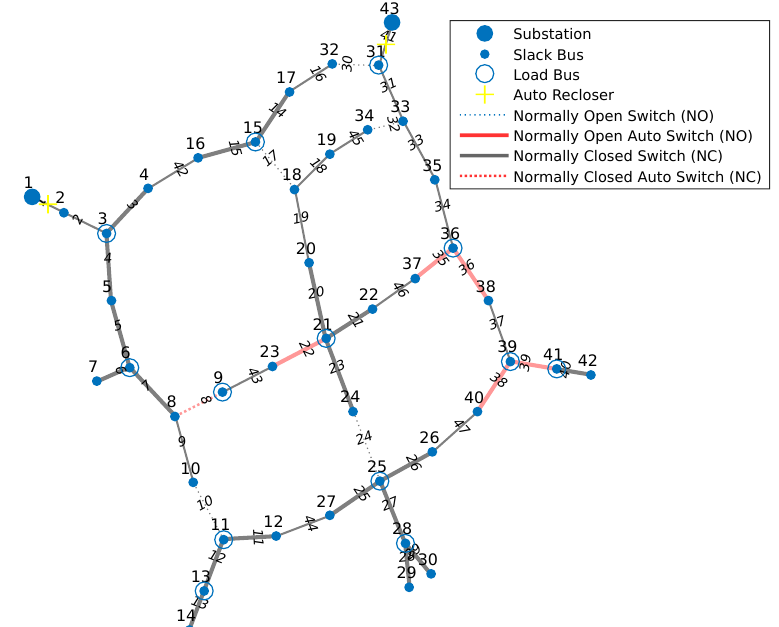
Figure 2. Optimal of the 43-bar network. In Figure 3, we can see the performance by iteration and by time. It shows the sudden drop in the cost of the network right after the initial heuristic, represented until the 4th iteration in 57 min, a drop of 79.09% compared to the initial configuration, and in the 10th iteration with 4 h and 44 min, a drop of 90.01% compared to the initial configuration. Between the 61st, in 25 h and 1 min, and the last iteration, there is a drop of less than 1% in the cost of the network. GABC converges on the 99th iteration in 38 h and 47 min showing a total improvement of 96.13% over the initial configuration.